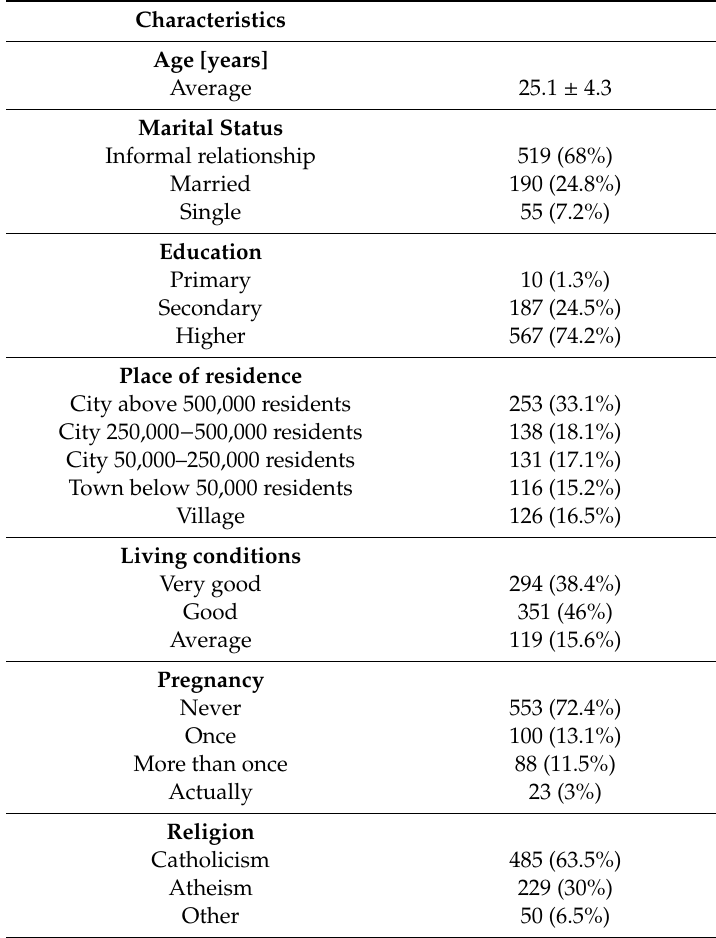
Table 1. Demographic characteristics of the study participants.